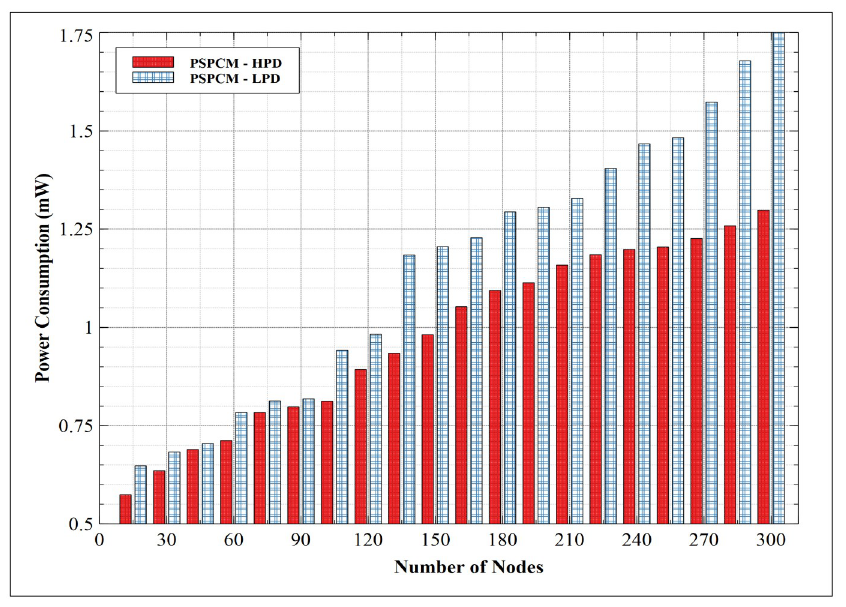
Fig 13. Power consumption—HPD vs